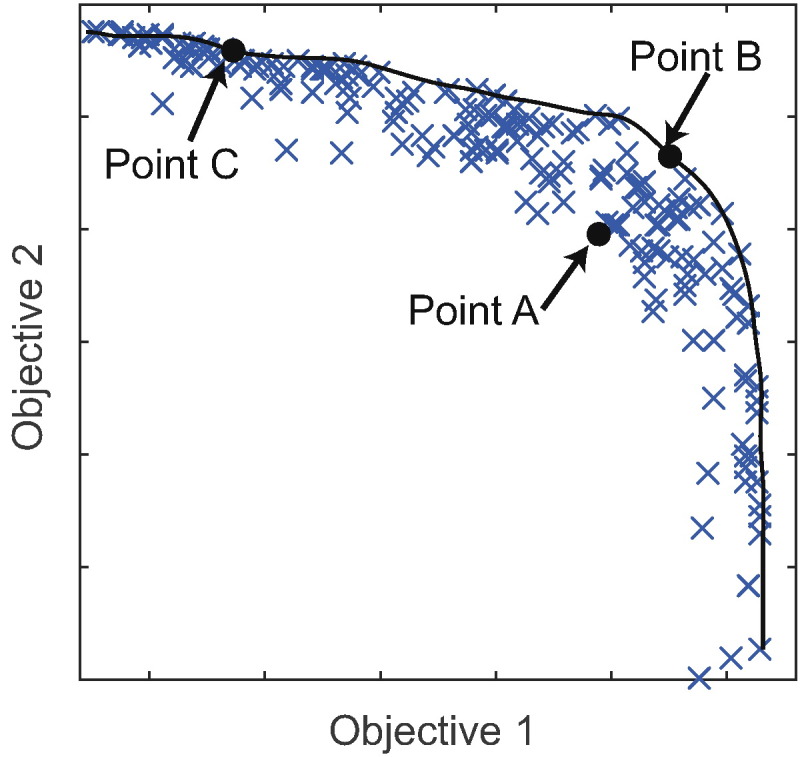
Example of how a Pareto front is identified from a number of points simulated by the model with the aim to improve multiple objectives (1 & 2) simultaneously. Point B is selected over point A because B scores better for both objectives. It can be seen that neither of points B or C dominates the other, because point B does better at objective 1 whilst point C improves on objective 2. Consequently, both are retained. The Pareto front (line) can be identified by connecting together all of the non-dominated points.